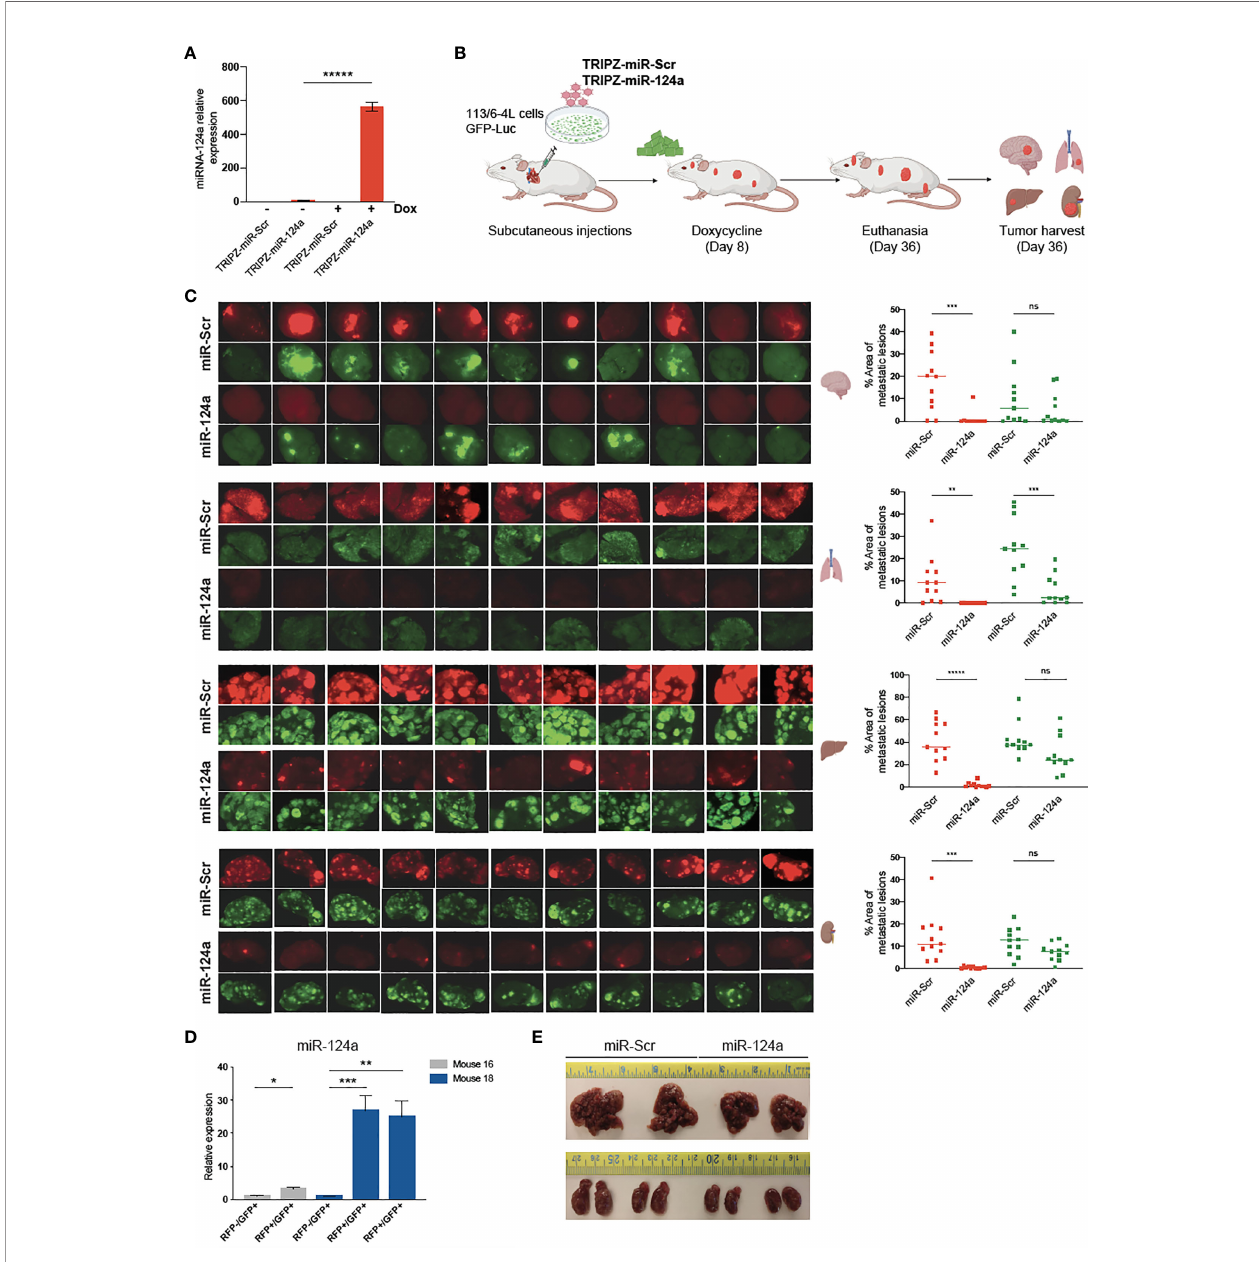
FIGURE 5 | miR-124a overexpression inhibits established metastases. (A) The 113/6-4L melanoma cells were transduced with GFP-Luciferase followed by TRIPZ- Scr or TRIPZ-miR-124a lentiviral infections. Ef fi cient miRNA-124 overexpression after doxycycline treatment in vitro was assessed by RT-qPCR (unpaired t test; *****p = 0.000005). (B) Schematic representation of in vivo metastasis assay with inducible overexpression of miR-124a: The 113/6-4L-GFP-Luciferase cells transduced with doxycycline-inducible control (TRIPZ-miR-Scr) or (TRIPZ-miR-124a) tagged with a tRFP reporter were selected with puromycin, and ultrasound- guided intracardiac injection was performed in NSG mice (n = 11 per group). Mice were initiated on doxycycline (200 mg/kg) chow 8 days post-injection. (C) RFP and GFP fl uorescence images of brain, lung, liver, and kidneys in all mice are shown, and the areas of metastatic lesions were plotted using ImageJ (red dots: RFP+ metastases; green dots: GFP+ metastases). Unpaired t test was used for statistical signi fi cance of differences in brain (***p = 0.0006 for RFP+ metastases in miR124a vs. miR-Scr group; ns, p = 0.274 for GFP+ in miR124a vs. miR-Scr group), lung (**p = 0.0041 for RFP+ metastases in miR124a vs. miR-Scr group; ***p = 0.00056 for GFP+ in miR124a vs. miR-Scr group), liver (*****p < 0.000001 for RFP+ metastases in miR124a vs. miR-Scr group; ns, p = 0.056 for GFP+ in miR124a vs. miR-Scr group), and kidney (***p = 0.00033 for RFP+ metastases in miR124a vs. miR-Scr group; ns, p = 0.058 for GFP+ in miR124a vs. miR-Scr group) metastases. (D) Expression of miR-124a in RFP-/GFP+ and RFP+/GFP+ liver metastatic foci dissected from two representative mice (#16 and #18) from the miR124a group is measured by quantitative RT-qPCR (unpaired t test; *p = 0.018 for mouse 16 and ***p = 0.0011 and **p = 0.005 for mouse 18). (E) Representative images of the liver and kidney sizes of two mice from both groups are shown. ns, non signi fi